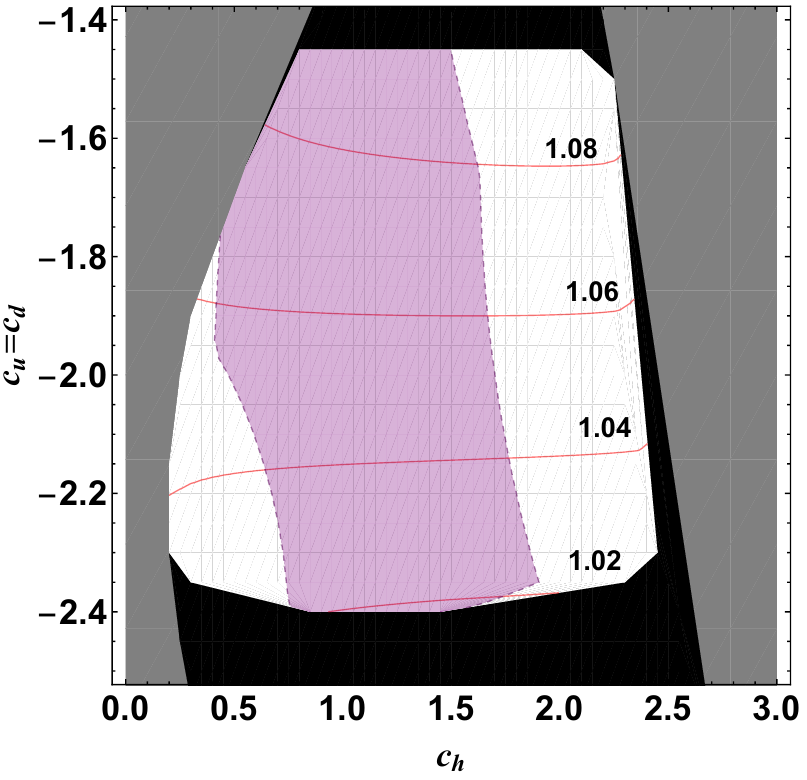
Figure 2 . The viable parameter region for m = 60 TeV and tan (cid:12) = 50 on c h - c u (= c d ) plane. 3 = 2 We (cid:12)x sign[ (cid:22) ] = (cid:0) 1 : The contours denote the mass ratio of the lightest chargino to the light- est neutralino. The black region contradicts with (4.1). The gray region is excluded due to a tachyonic/too-light scalar particle. On the purple range the lightest neutralino is the LSP, which is bino-like. Left (right) to the purple range, the LSP is the slepton (squark). Throughout the paper, we take the top mass as M t = 173 : 21 GeV and QCD coupling constant as (cid:11) s ( m Z ) = 0 : 1181